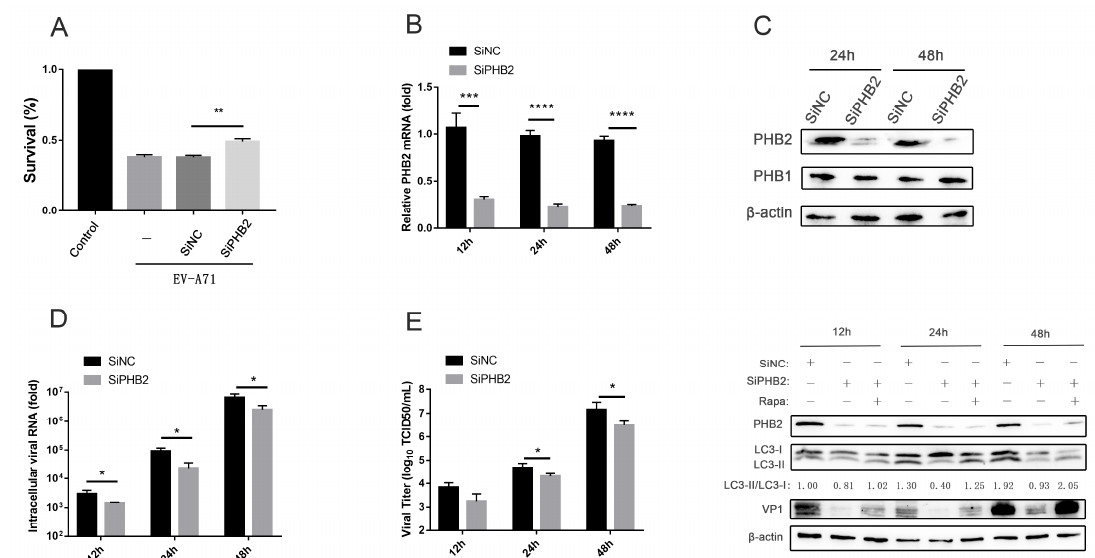
Figure 3. Knockdown of PHB2 inhibits EV-A71 infection and autophagy. ( A ) RD cells were transfected with SiNC or SiPHB2 for 24 h and then infected with EV-A71 (MOI = 5) for 24 h. The cell survival rate was determined by a CCK-8 assay. ( B – E ) RD cells were transfected with SiNC or SiPHB2 for 24 h and then infected with EV-A71 (MOI = 1). At different time points after infection, PHB2 mRNA ( B ) and intracellular viral RNA ( D ) levels were measured via RT-qPCR, (E) viral titers in the supernatants of infected cells were determined by TCID50 assays, ( C ) and ( F ) proteins were detected by Western blot analysis. * p < 0.05, ** p < 0.01, *** p < 0.001, and **** p < 0.0001.